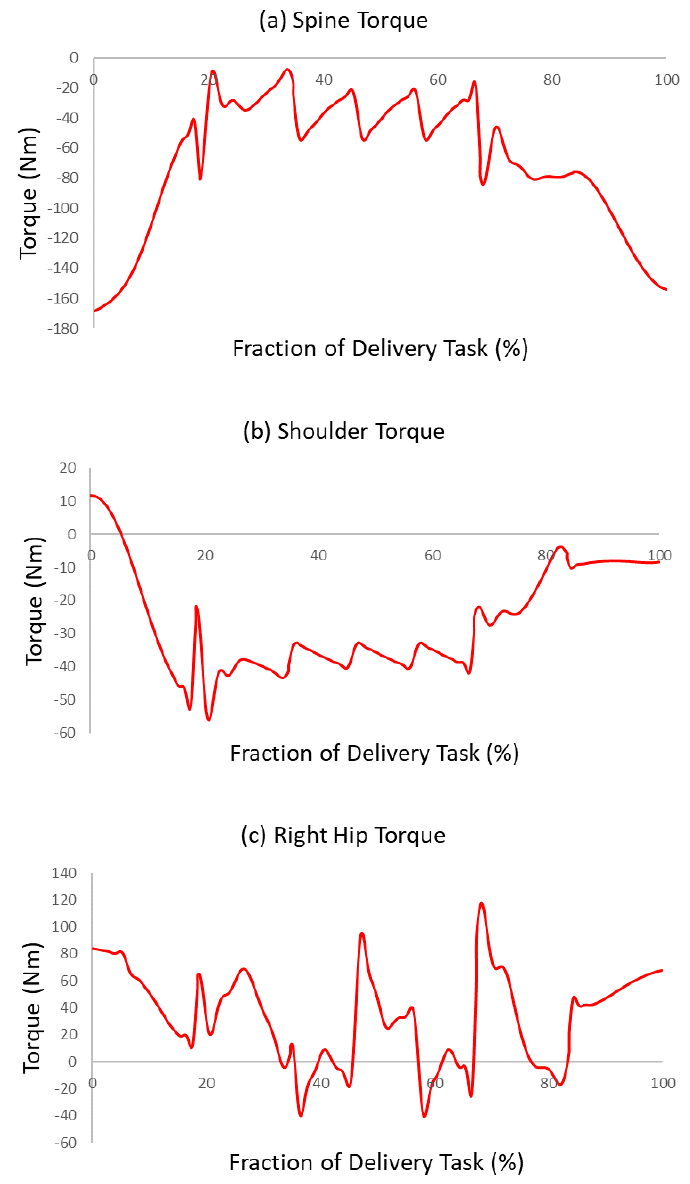
Figure 6. Joint torque profiles for deliver motion: ( a ) spine, ( b ) shoulder, and ( c ) right hip.